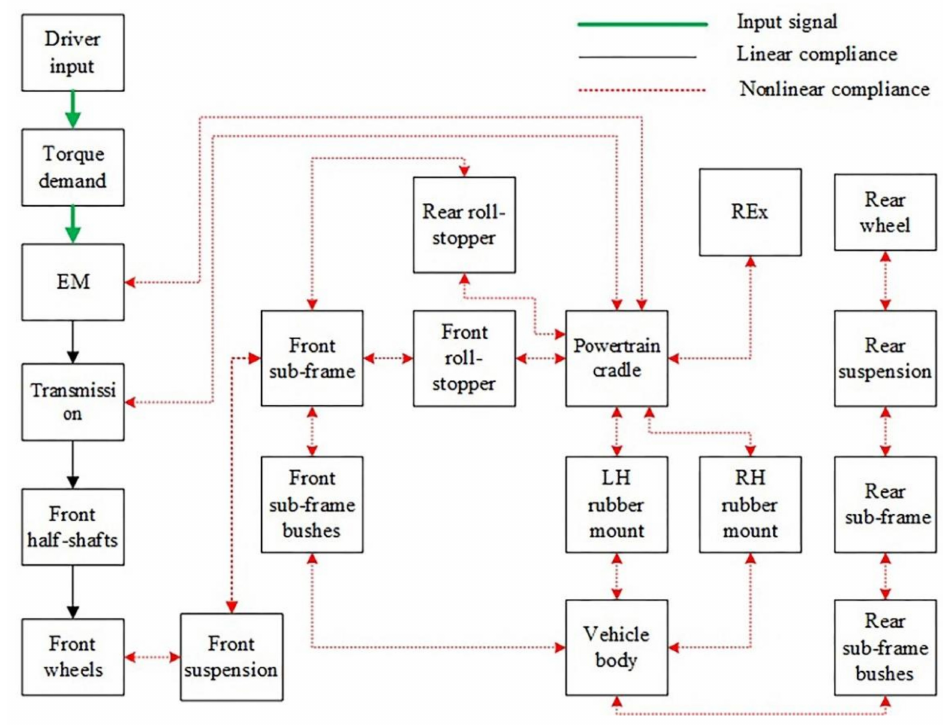
Figure 2. Block diagram of 2WD REEV system architecture interaction.